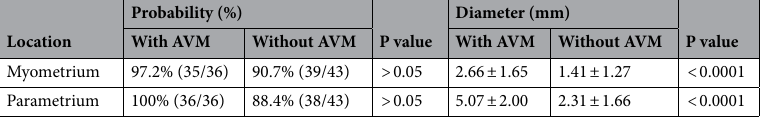
Table 2. Prevalence and mean diameter of flow voids in women with and without uterine